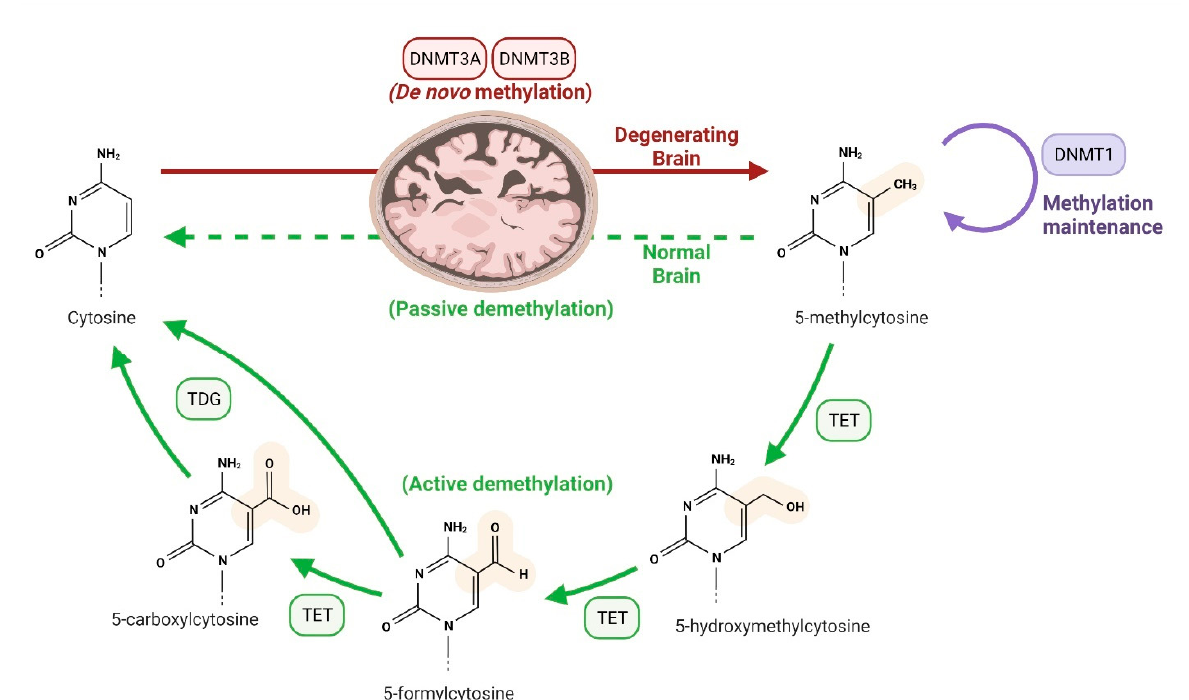
Figure 1. A systemic representation of DNA methylation and demethylation. By means of the action of DNA methyltransferases, the methyl group is transferred to the 5th carbon in cytosine. Generally, DNA methylation is initiated by DNMT3A/3B ( de novo pathway) and is maintained by DNMT1. Most gene expression is suppressed by DNA methylation, which contributes to the development of neurodegeneration. On the other hand, methylated cytosine turned into cytosine through an active/passive demethylation process. This cycle regulates the gene expression, while under certain environmental conditions, abnormality in this cycle may contribute to the development of neurodegenerative diseases.